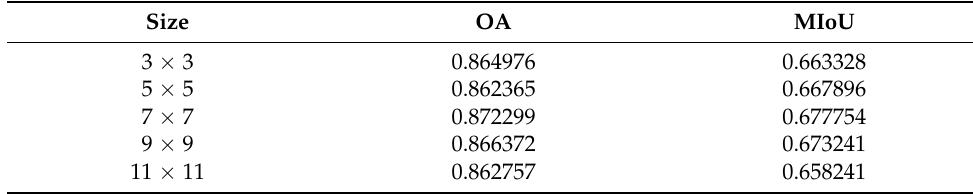
Table 4. Model performance with different kernel